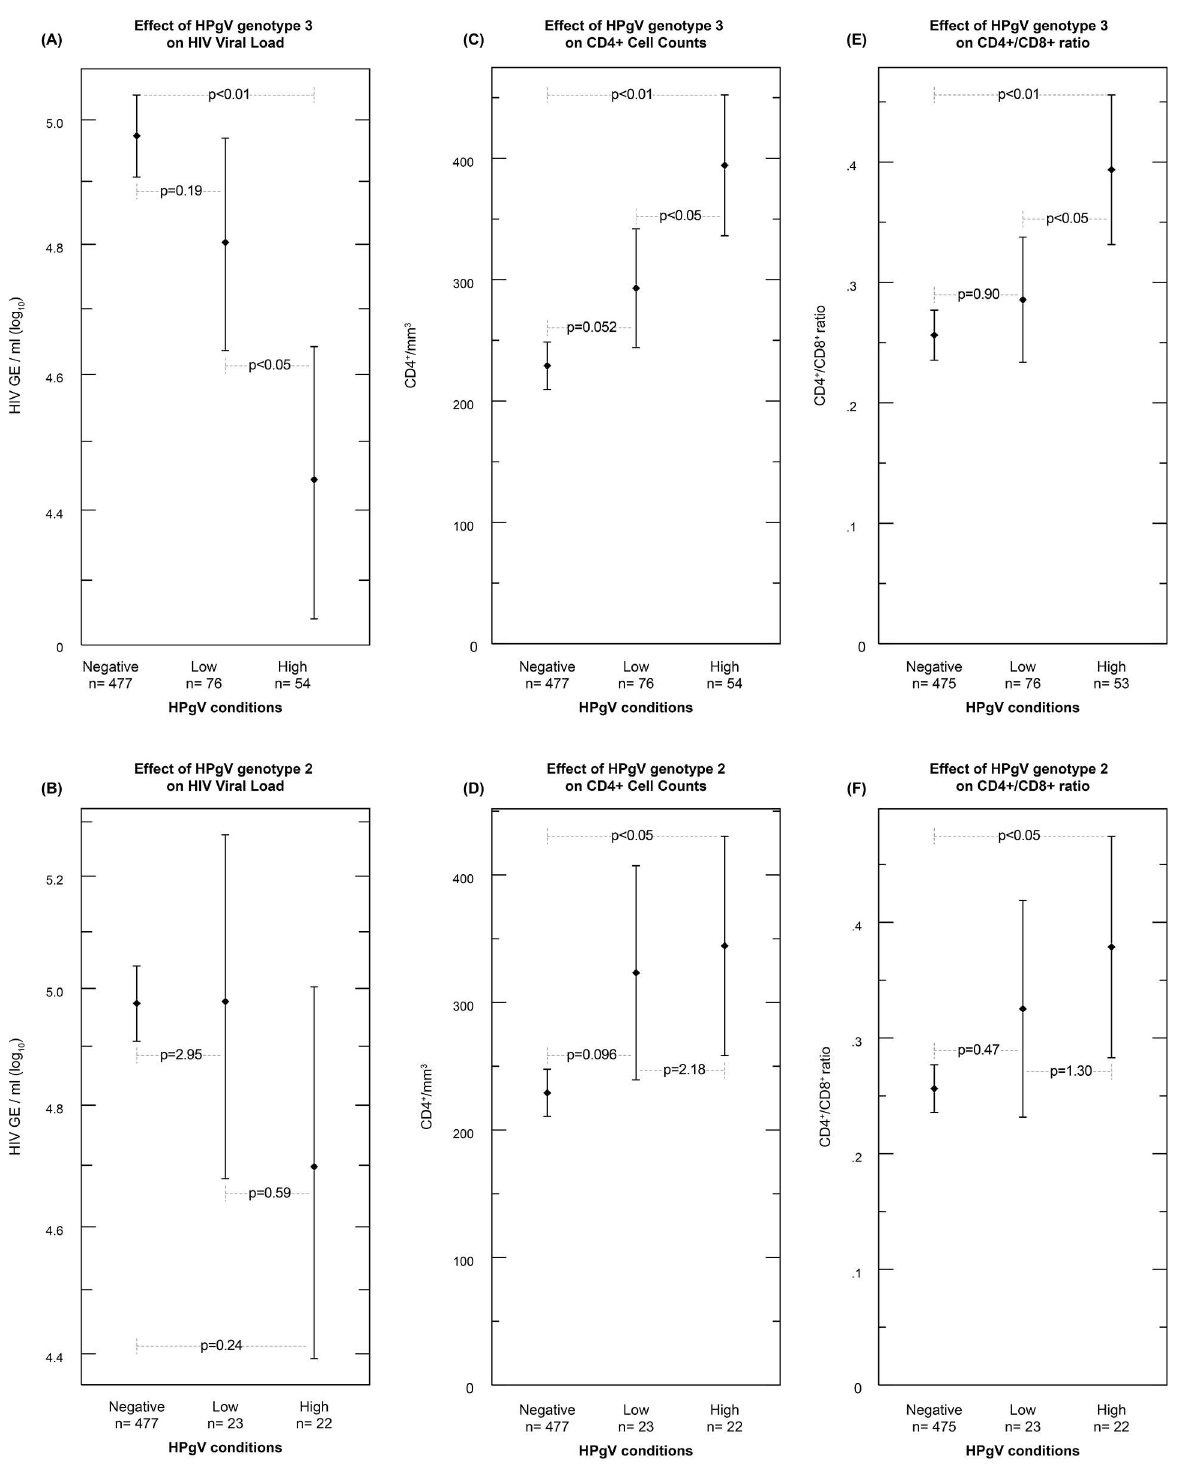
Fig 4. Effects of HPgV genotype (2 or 3) on surrogate markers of HIV progression. Each graph shows the differencesbetweenthe means of: (A and B) HIV viral load/ml(log 10 ), (C and D) CD4 + cell counts (CD4 + /mm 3 ), and (E and F) CD4 + /CD8 + ratio, in the ART- na ï vepopulationaccordingto their HPgV condition(-negative,-low, or -high) and genotype3 (A, C and E) and genotype2 (B, D and F). Significantdifferences are considered at p < 0.05.